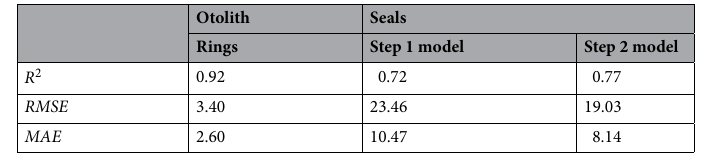
Table 1. Numerical performance of the proposed method on the randomly selected test sets for both applications. The performance of the seal counting application increased after fine-tuning the Step 1 model using ‘seal subset 2’ (Step 2